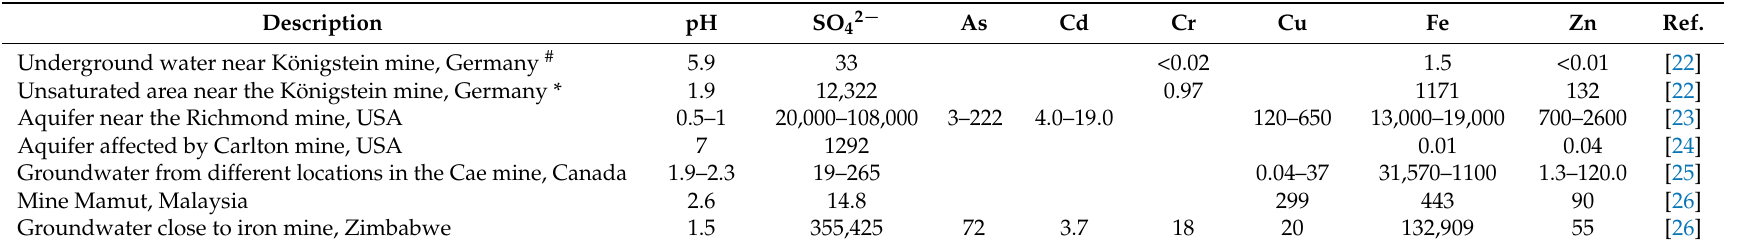
Table 1. Species content (mg/L) and pH of groundwater contaminated with